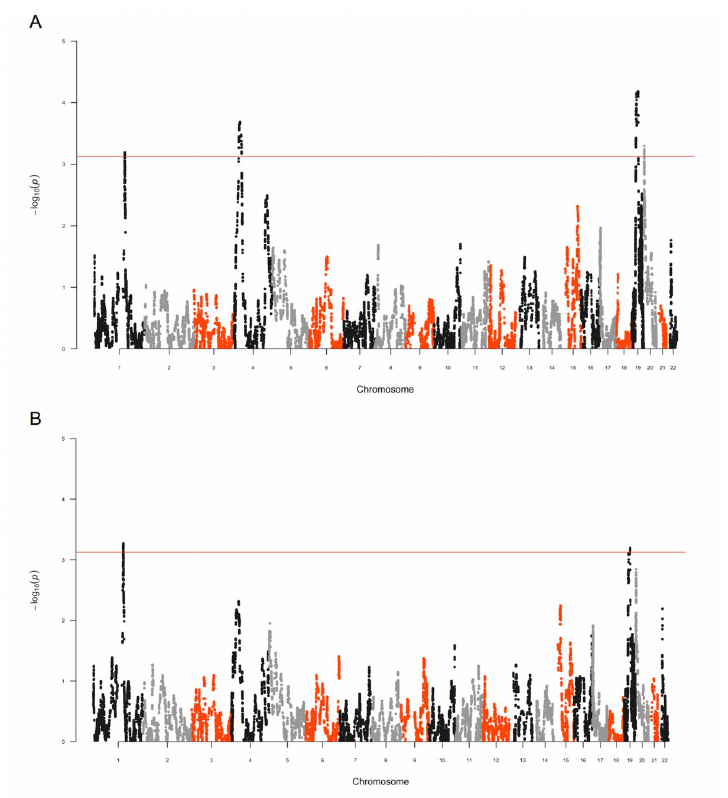
Fig 1. Manhattan plot indicates chromosomal regions where local African ancestry is associated with DBP or MAP. A) At chromosomal regions 1q21.2–21.3 ( β = 5.28, P -value = 6.39E-04), 4p15.1 ( β = -7.94, P -value = 2.07E-04), 19q12 ( β = -6.82, P -value = 6.56E-05), and 20p13 ( β = 5.89, P -value = 5.04E-04), local African ancestry was significantly associated with DBP. B) Two of the above regions overlapped regions where local African ancestry was significantly associated with MAP: 1q21.2–21.3 ( β = 5.86, P -value = 5.32E-04) and 19q12 ( β = -6.40, P -value = 6.37E- 04). The red bar indicates the exome-wide significance threshold of 3.13.